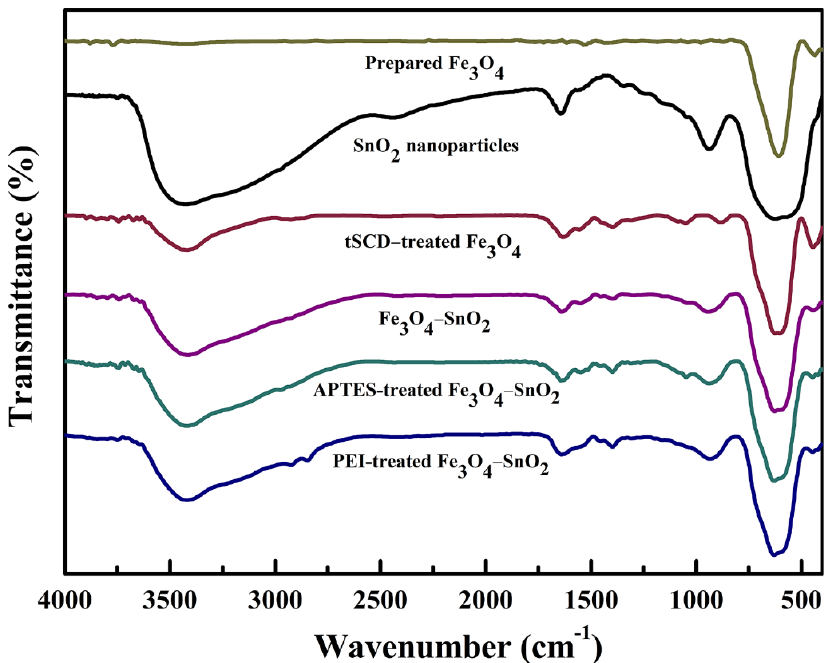
Figure 2. FTIR spectra of the as-prepared Fe 3 O 4 , SnO 2 , tSCD-treated Fe 3 O 4 , Fe 3 O 4 -SnO 2 , APTES- treated Fe 3 O 4 -SnO 2 , and PEI-treated Fe 3 O 4 -SnO 2